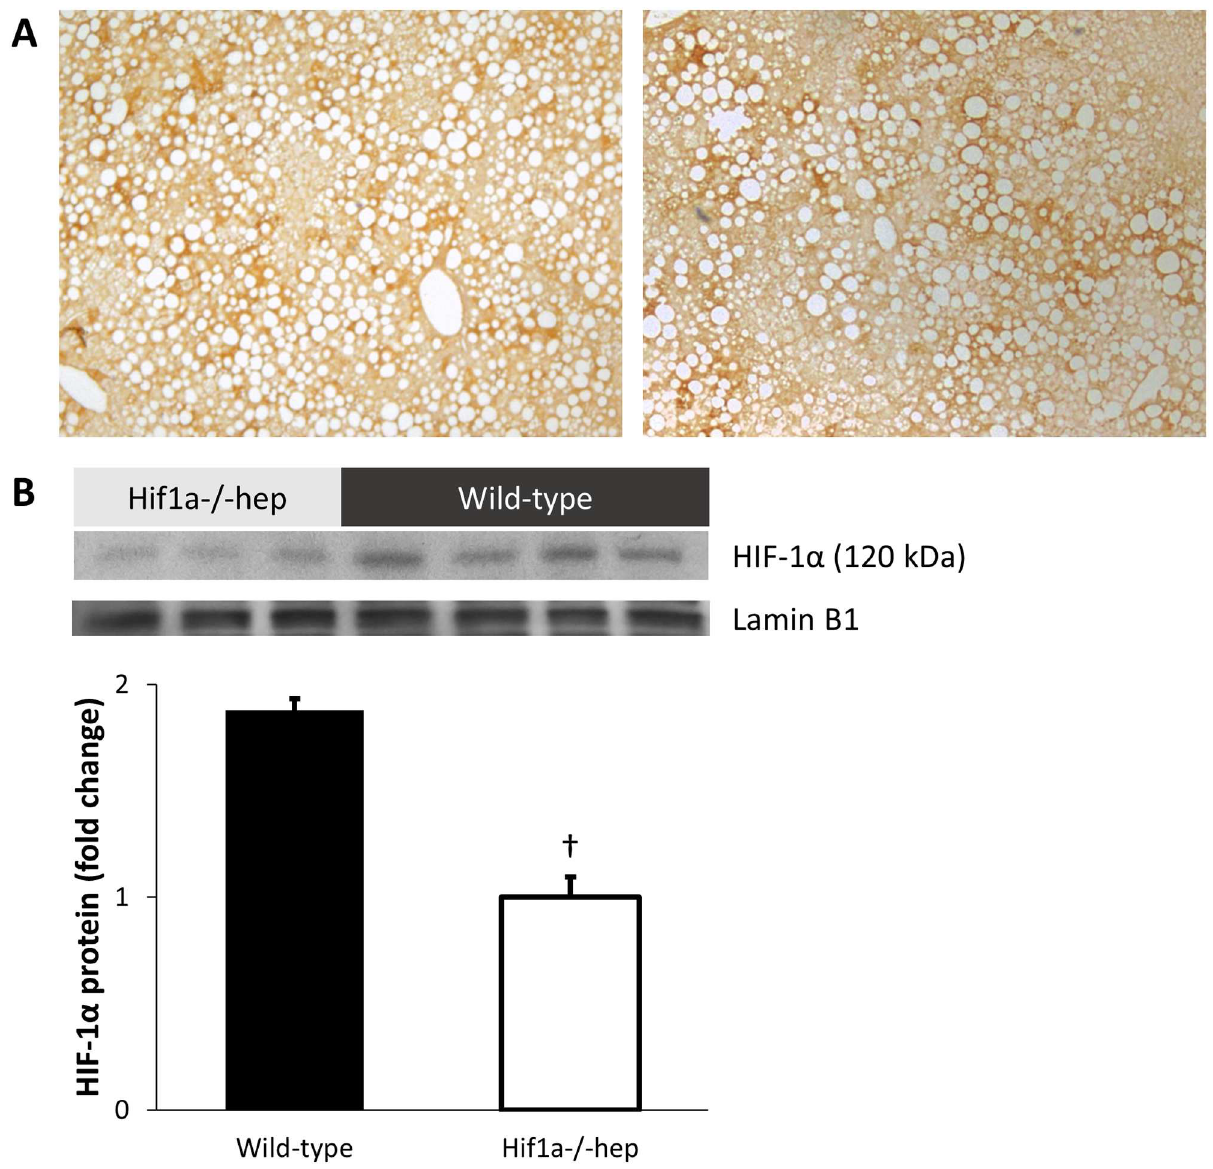
Fig 3. Liver hypoxic profile. (A) Wild-type (left) and Hif1a -/- hep (right) liver tissue was similarlyhypoxic after six months on an HTFD, as qualitativelyassessed by Hypoxyprobestain. (B) As expected, HIF-1 α protein levels were reducedin Hif1a -/- hep mice. Some